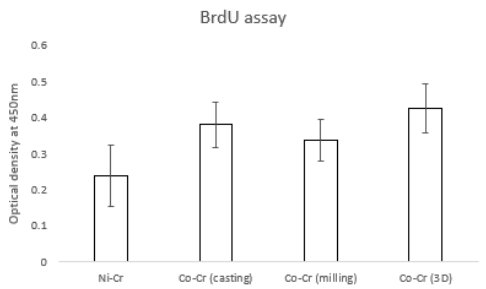
Figure 6. The value of proliferated hADSCs that were incorporated with BrdU. There were significant differences between the Ni-Cr group and the other groups (the bar represents mean ± SD).